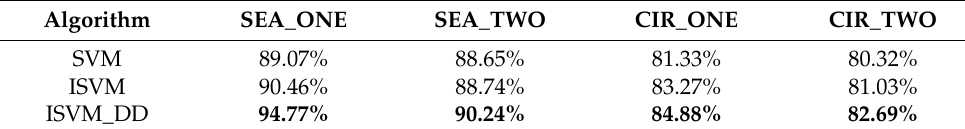
Table 10. The average accuracy of different types and different degrees of concept drift. Algorithm